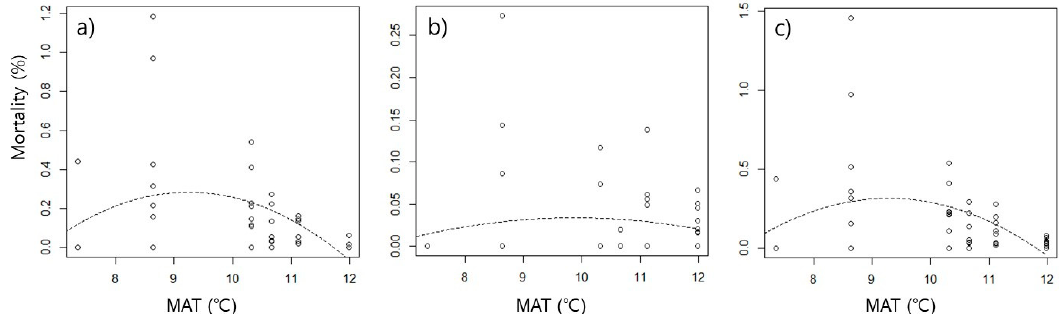
Figure 2. Mortality rate (%) of all ant species caused by food competition along the temperature gradient. ( a ) Interspecific competition, ( b ) intraspecific competition, and ( c ) total. The experiment was carried out with eight replicates at each temperature condition, and their mortality rates were presented in the scatter plot. The fitted lines are based on the quadratic regression models according to significant influences shown in Table 4. MAT: mean annual temperature. Table 6. Results of Poisson regression model on relationships between mortality from food compe- tition and temperature. AT: atmospheric temperature measured 1 m above ground during survey; MAT: mean annual temperature measured by data logger at 10 cm